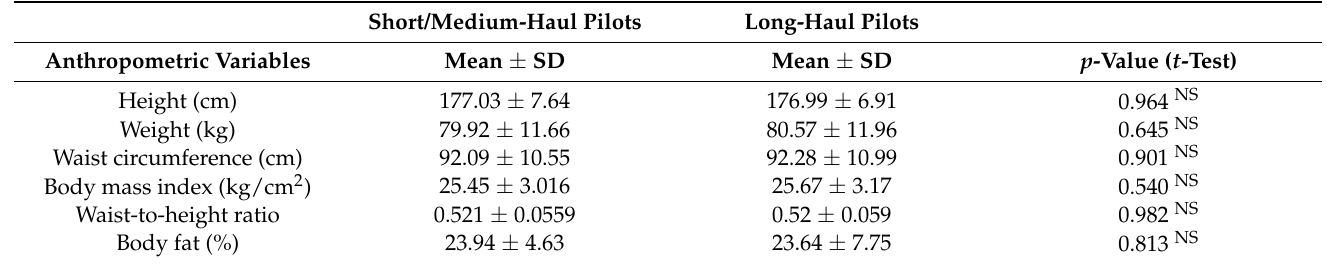
Table 1. Anthropometric profile according to flight type.